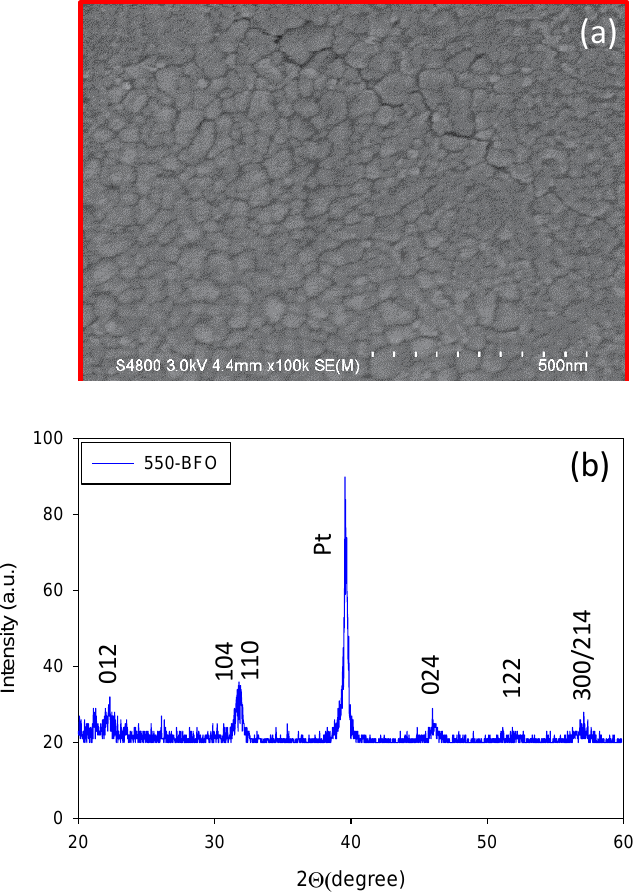
Figure 2. ( a ) SEM image of BFO film annealed at 550 °C. ( b ) XRD pattern of BFO film annealed at 550 °C.